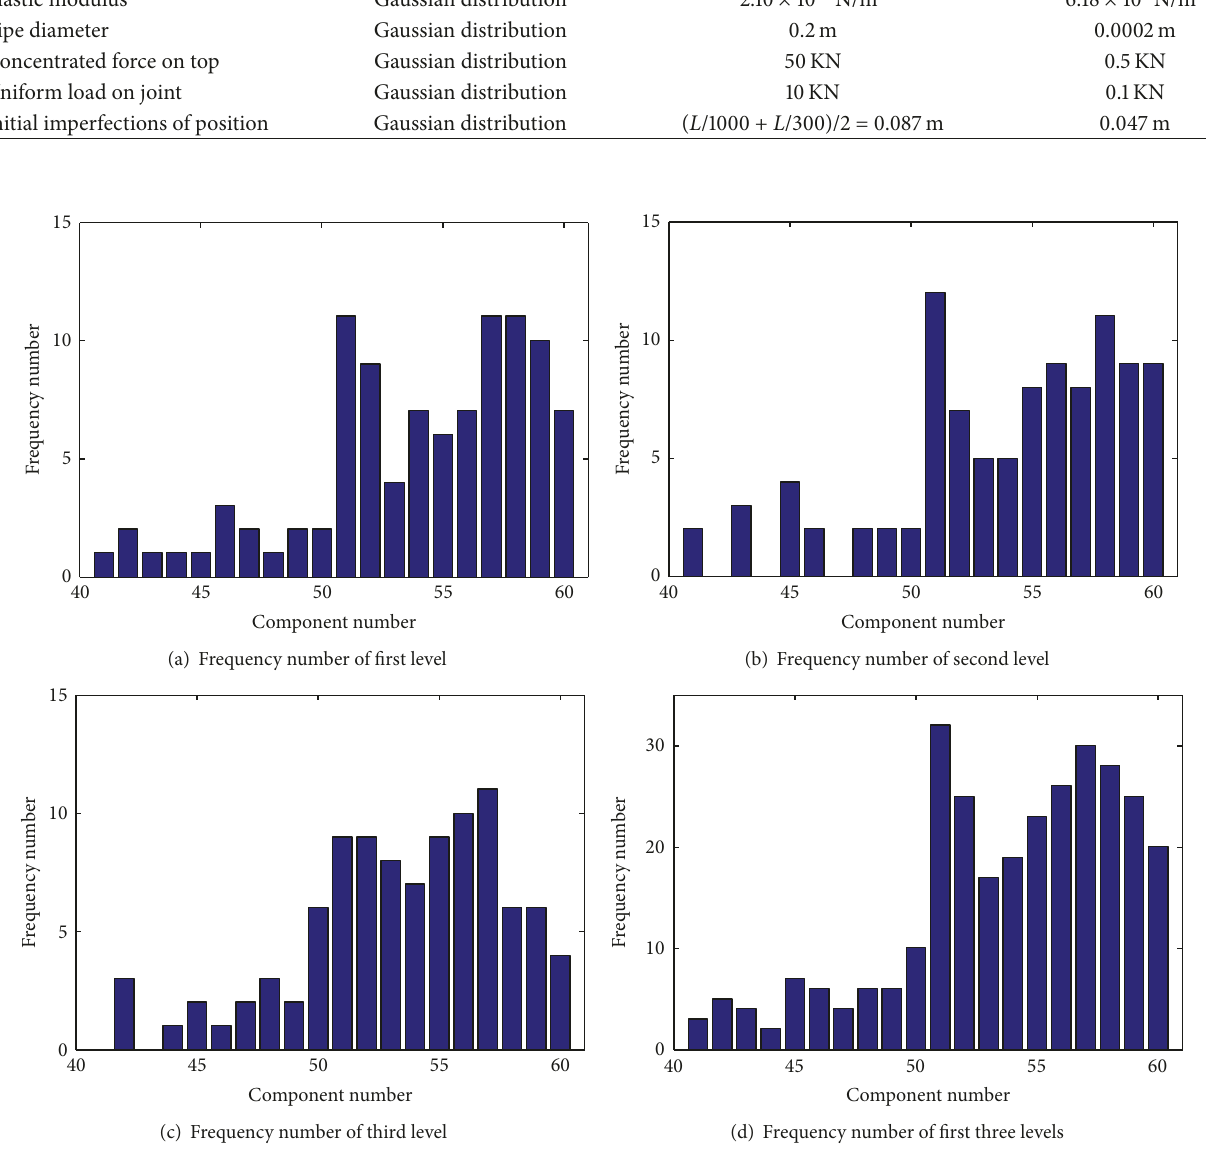
Figure 10: Frequency number under uniform load